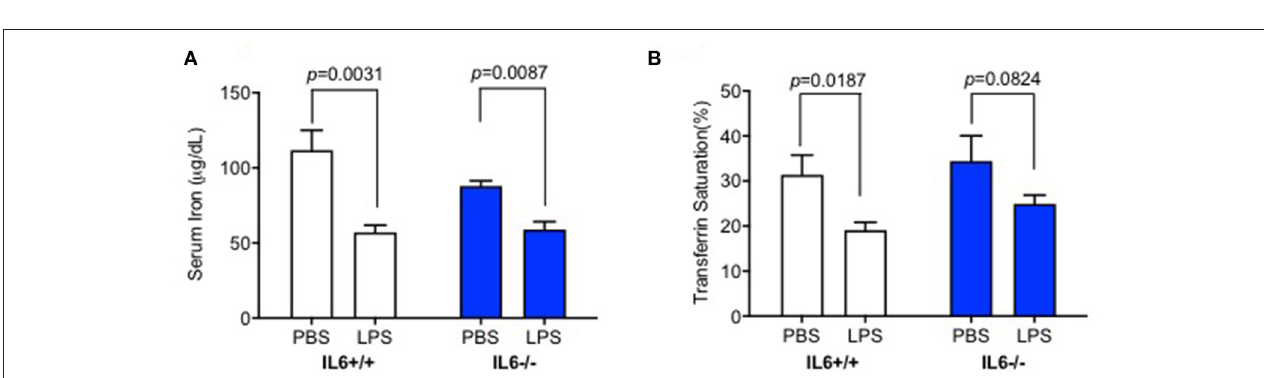
FIGURE 2 | IL-6 deficiency diminished the decrease of serum iron and transferrin saturation induced by lipopolysaccharide (LPS) injection. IL-6 + / + and IL6–/– mice were administered with phosphate-buffered saline (PBS) or LPS intracerebroventricular (ICV) injection and sacrificed after 6h; serum iron concentration (A) and transferrin saturation (B) were measured. Data are presented as means ± SEM (% control) (IL-6 + / + : PBS = 4, LPS = 6; IL-6–/–: PBS = 3, LPS = 4). Analysis between the treatments was done via two-way ANOVA with Sidak’s post hoc